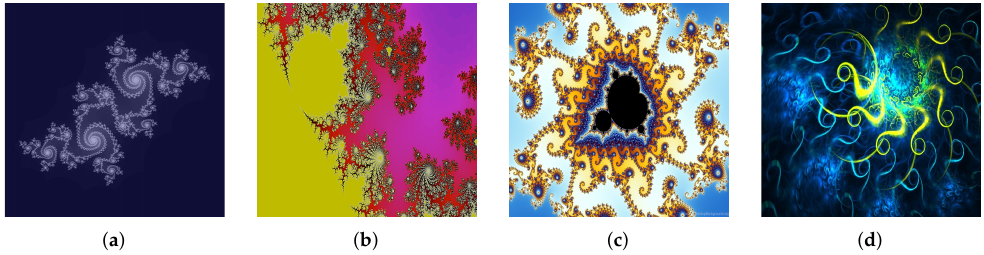
Figure 21. Examples of still fractal screensavers ( a ) Julia, ( b , c ) Mandelbrot zooms, and ( d ) a fractal flame.